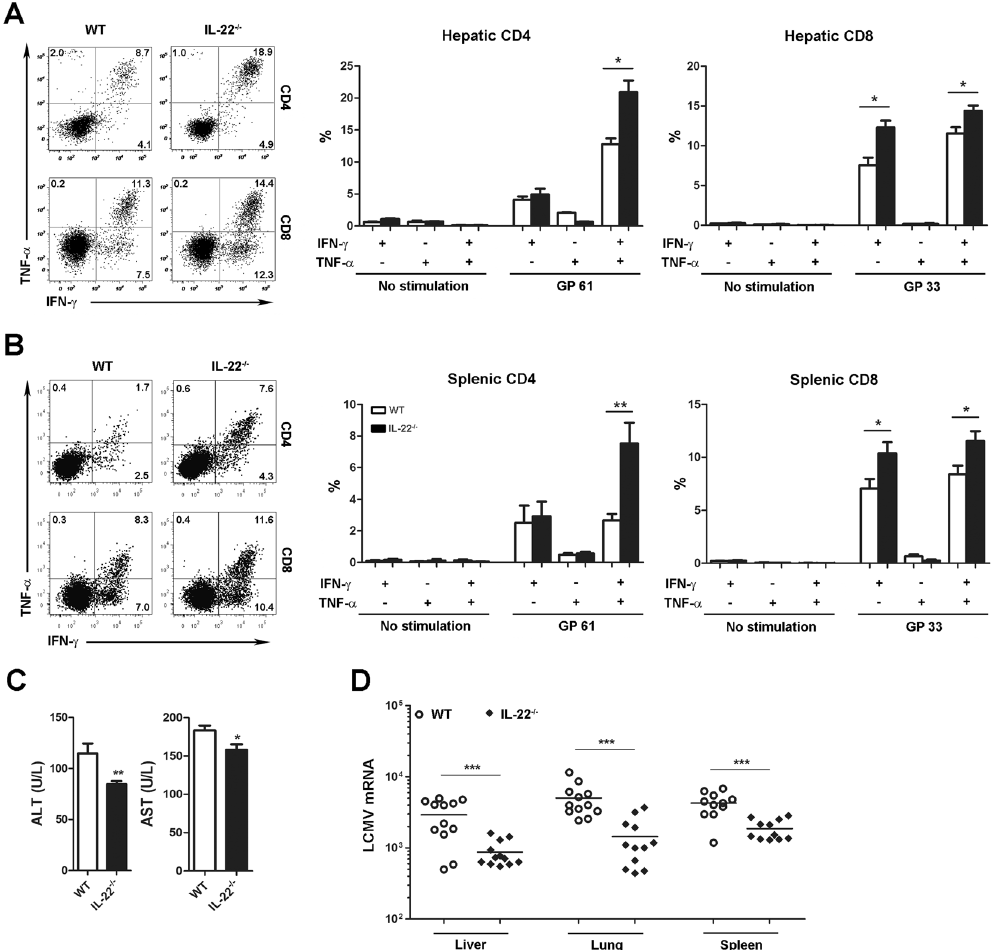
Figure 5. IL-22 deficiency augments T cell anti-viral activities during acute viral infection. WT and IL - 22 − / − mice were infected with LCMV Arm (2 × 10 5 pfu/mouse) for 7 days. ( A and B ) Leukocytes were isolated and incubated with or without LCMV peptide GP 61 or GP 33 for 5 h. IFN- γ and TNF- α production in viral-specific CD4 + and CD8 + T cells in the liver ( A ) and spleen ( B ) was determined by flow cytometry. ( C ) Serum ALT and AST levels were tested. ( D ) Expression of viral mRNA in the liver, lung and spleen tissues at 7 dpi was determined by qPCR. Data are representative of three independent experiments. The results are expressed as the mean ± SEM ( n = 9–12). * p < 0.05; ** p < 0.01; *** p <